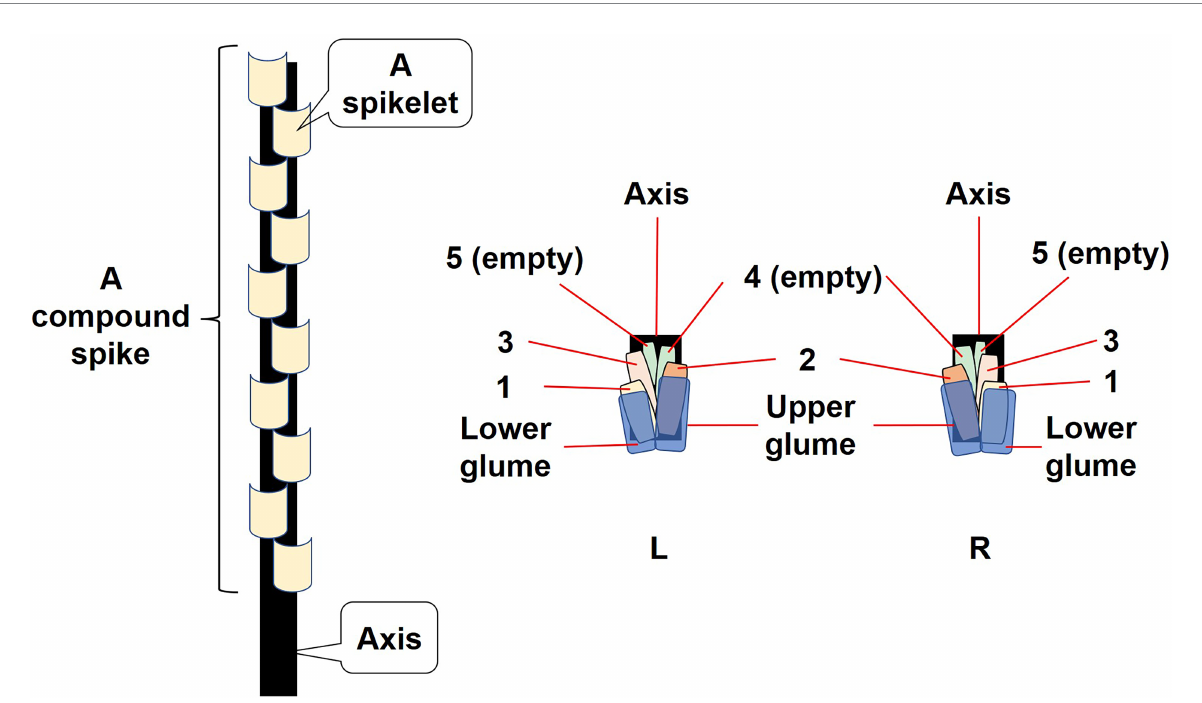
FIGURE 1 Compound spike and spikelets of Aegilops tauschii . The diagram shows the gradation of spikelets in the compound spike. L represents a spikelet with the developmental direction of the basal seed to the left; R represents a spikelet with the developmental direction of the basal seed to the right. Both types of spikelets are dispersed with a small piece of the broken axis attached to them. Numbers 1–5 refer to seeds from the most basal position to the most distal position in a spikelet. The seed in positions 1, 2 and 3 is filled, and these seeds were placed in study groups 1, 2 and 3, respectively. Seeds in position 4 and 5 are not